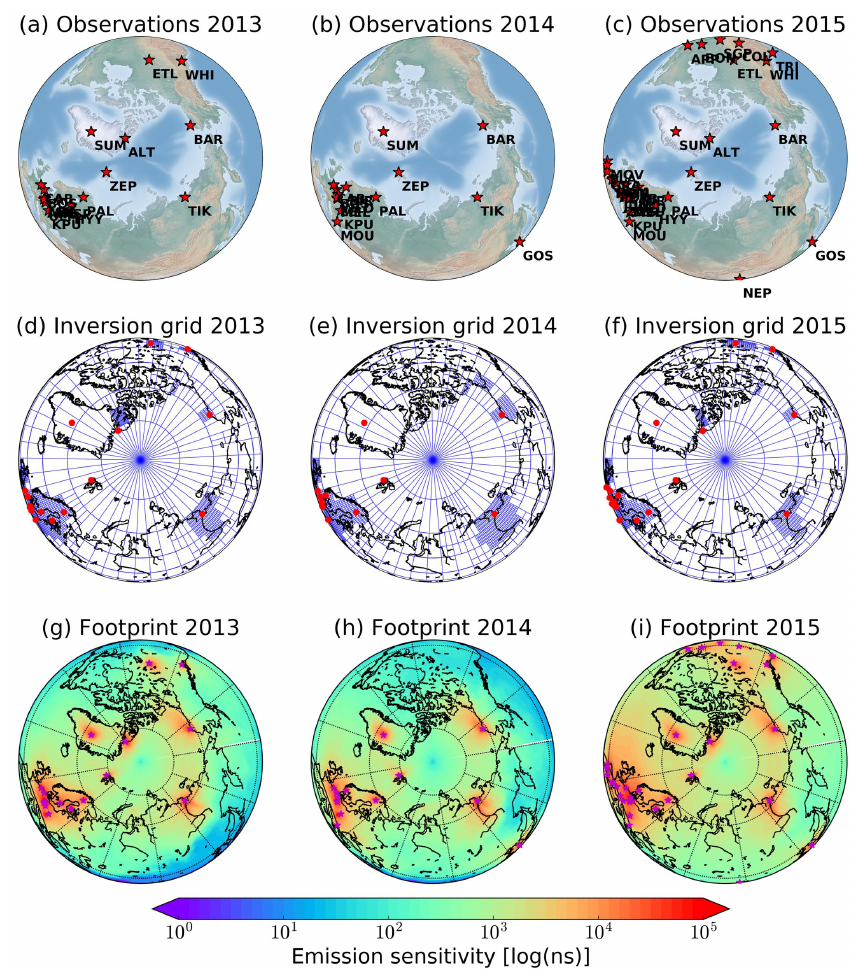
Figure 1. Observation network used for the present inversion (a, b, c) , and variable-resolution grid used for the inversion (d, e, f) also showing the location of the observation sites (red stars) for the 2013–2015 period. Sensitivity to the surface emissions (i.e. the footprint emission sensitivity or equivalent source–receptor relationship) integrated over all observation sites and all time steps (g, h, i) for the years 2013, 2014 and 2015 (units of